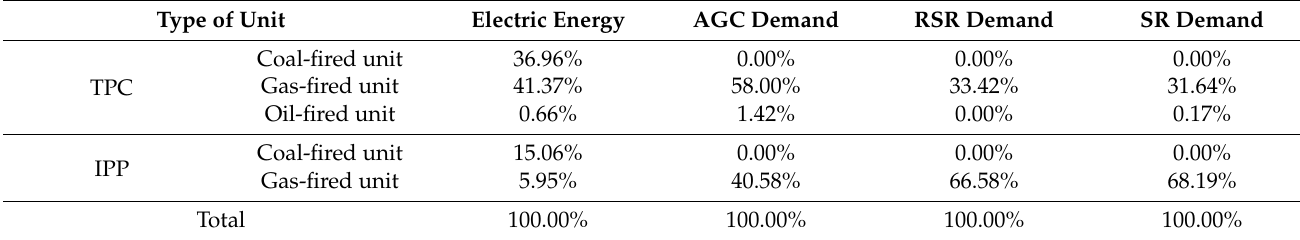
Table 2. Proportions of various units on a typical non-summer